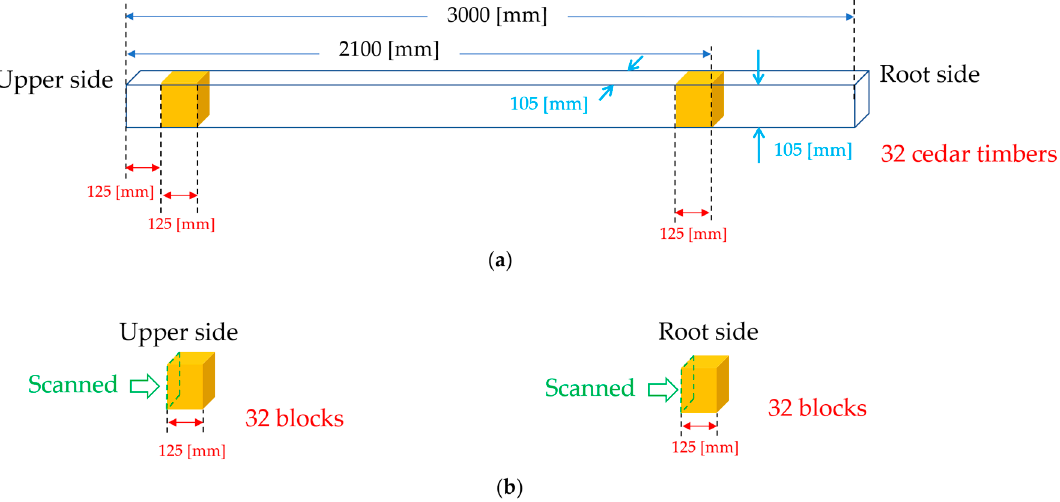
Figure 4. Timber details and scanning method for cross-sectional images. ( a ) Size of 32 square cedar timbers. Orange block pieces were cut out; ( b ) We scanned the images of the cross-sections surrounded by the green dashed lines.